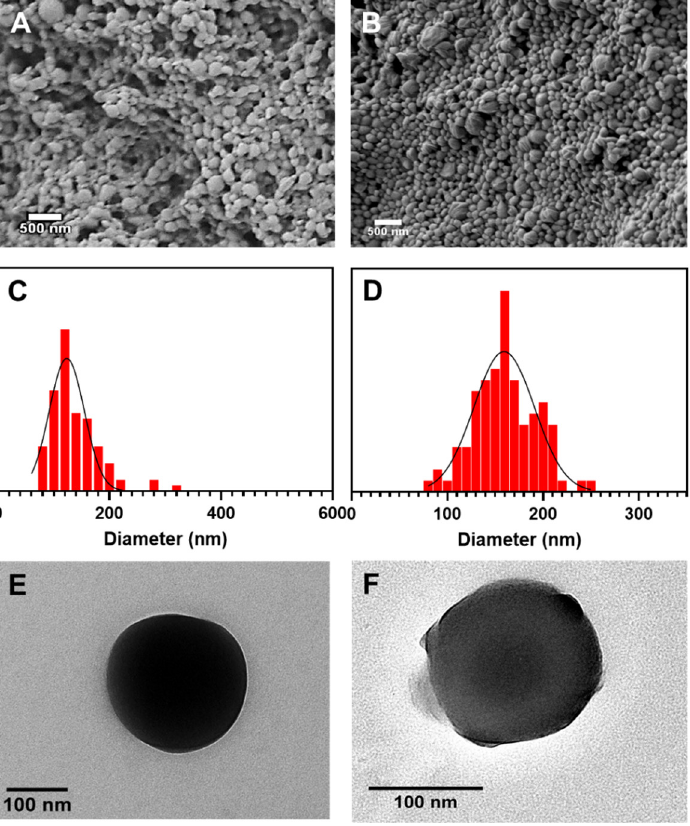
Figure 1. SEM image of PCL NPs ( A ) and PCL-AMB NPs ( B ). Size distribution of PCL NPs ( C ) and PCL-AMB NPs ( D ). TEM images of PCL NPs ( E ) and PCL-AMB NPs ( F